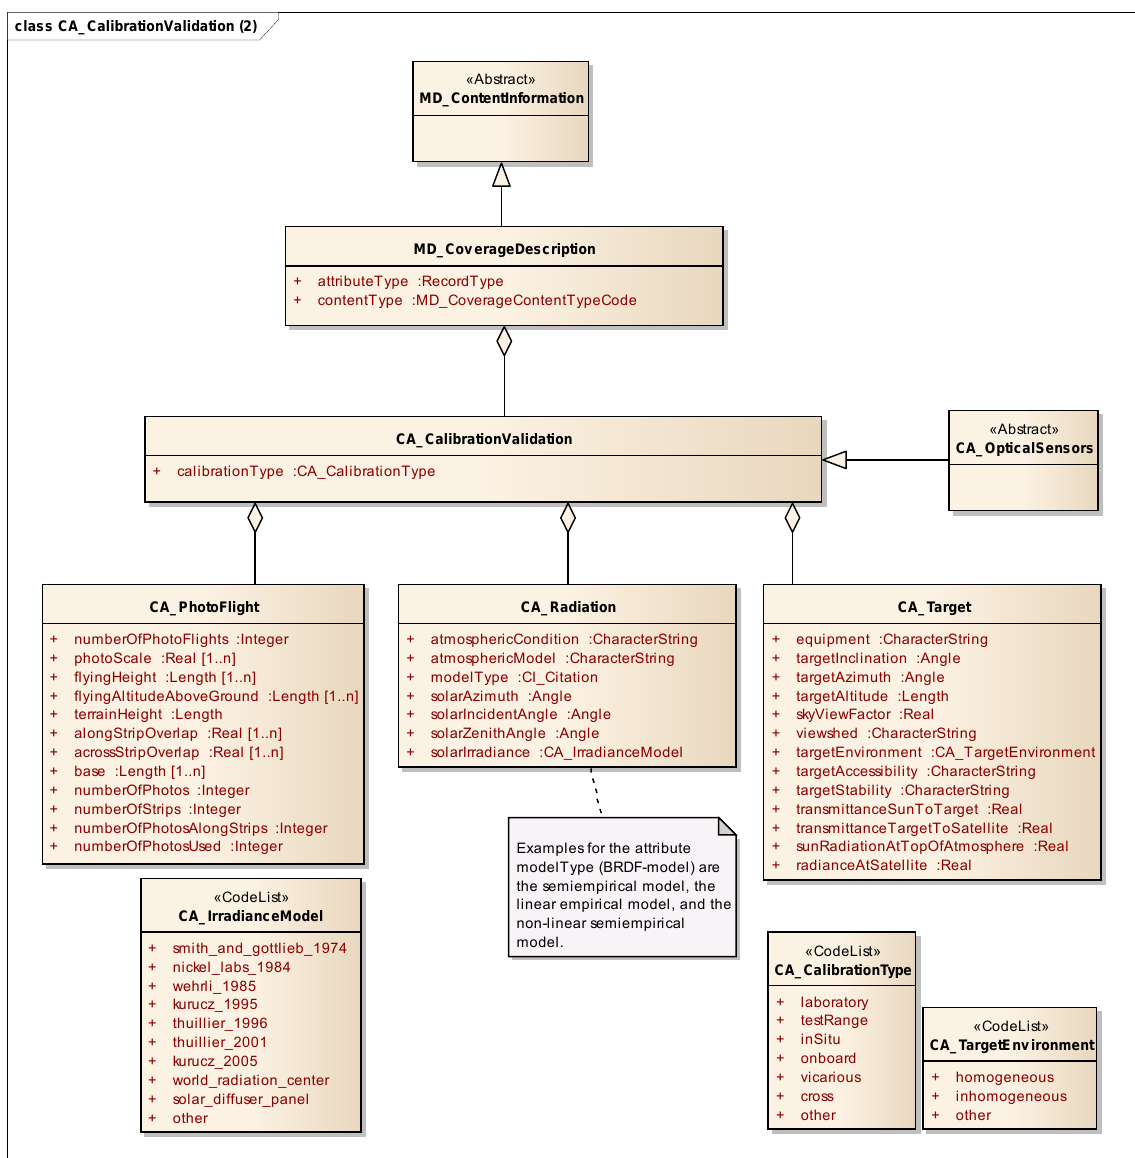
Figure 1. Top-level class model of the ISO/TS 19159-1 “Calibration and validation of remote sensing imagery sensors and data – Part 1: Optical sensors” (ISO/TS 19159-1